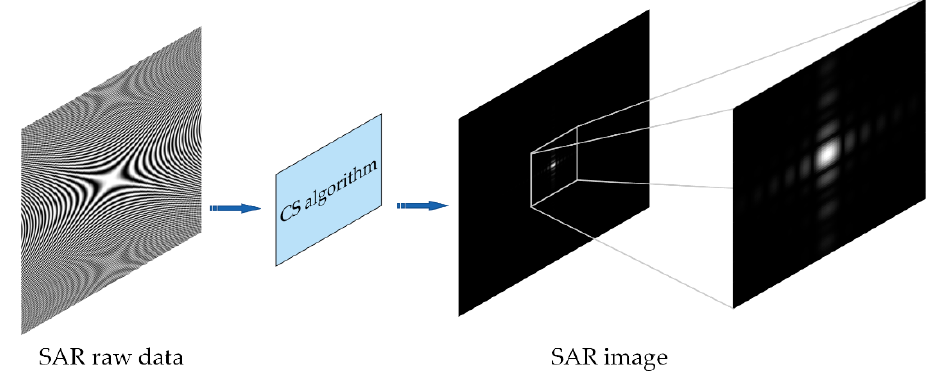
Figure 1. Flowchart of the chirp scaling (CS) algorithm.